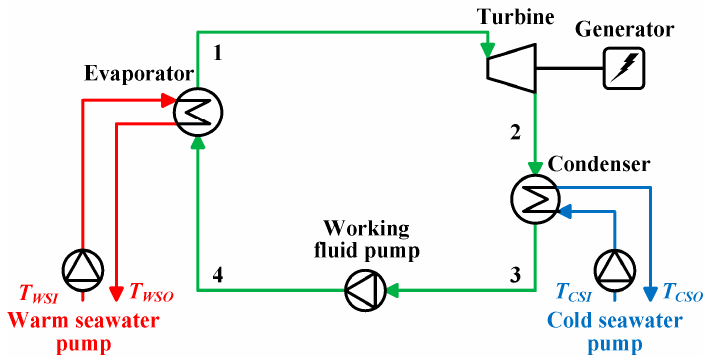
Figure 1. Rankine cycle flow.